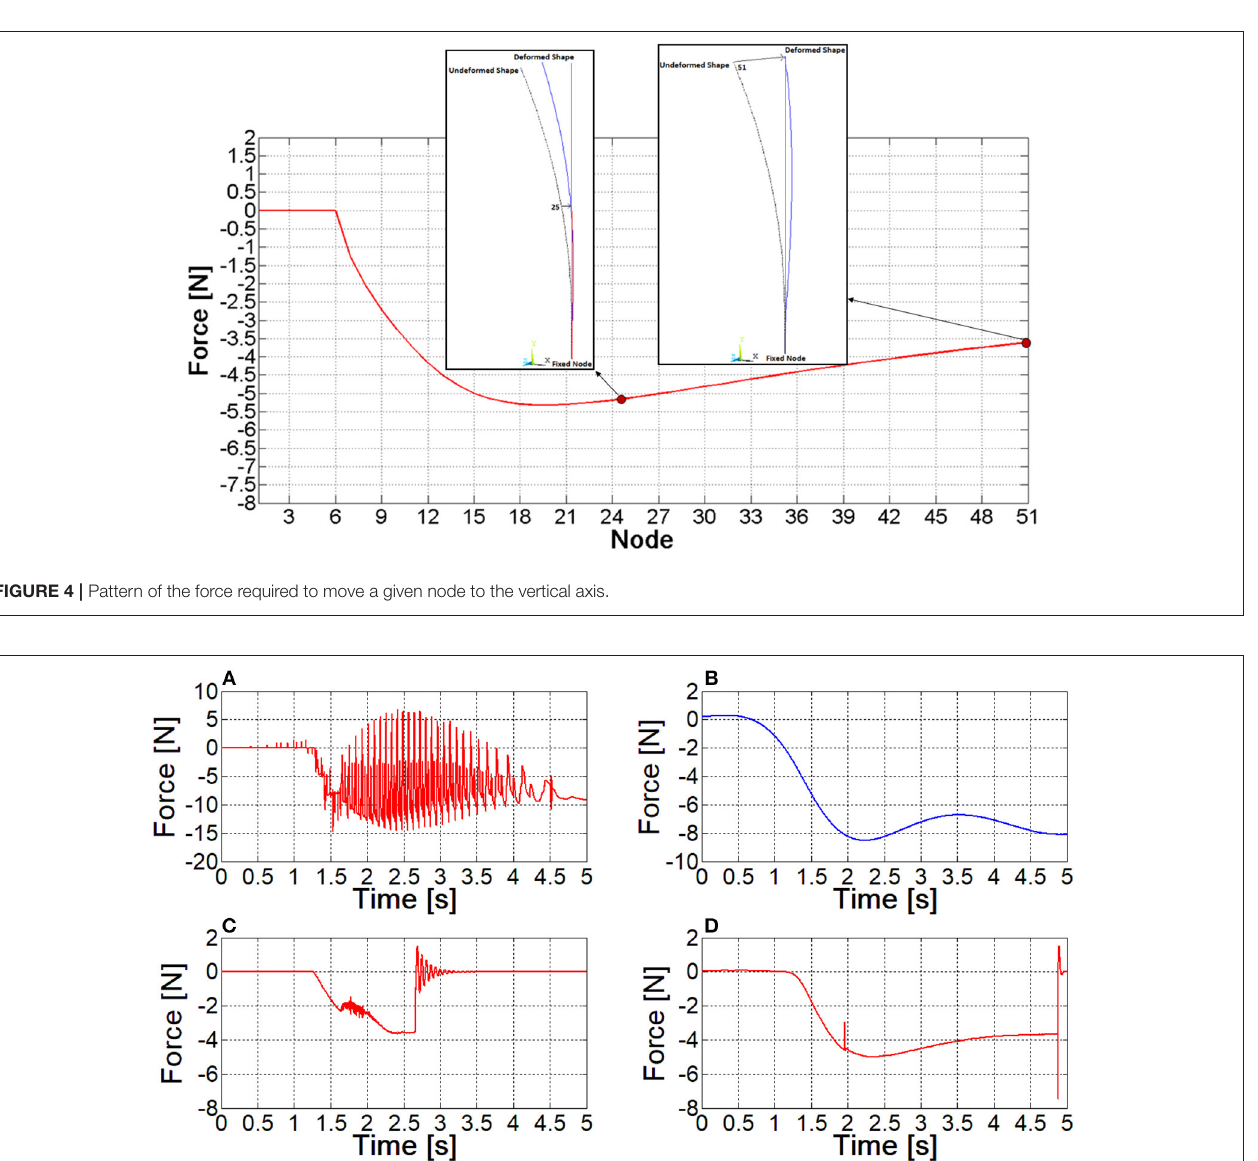
FIGURE 5 | The contact force between the nail and the sliding ring, as resulting from different models; (A) lumped parameters model; (B) filtered curve of lumped parameters model result; (C) flexible body model; (D) FE Part model.